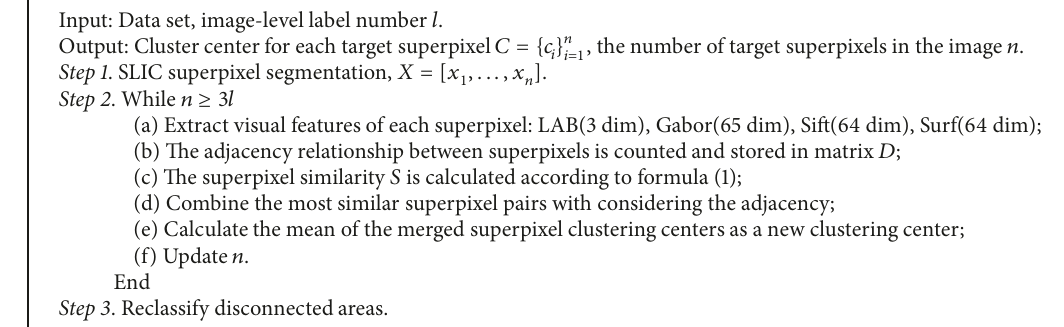
Algorithm 1: Superpixel merging